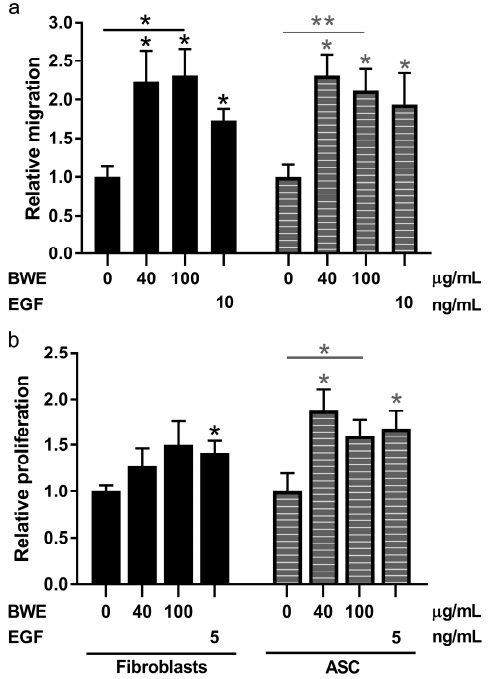
Figure 5. Migration scratch assay and proliferation assay using dermal fibroblasts and adipose tissue-derived mesenchymal stromal cells. ( a ) Relative migration values of fibroblasts and Adipose tissue-derived mesenchymal Stromal Cells (ASC) cultured in the presence of BWE or epidermal growth factor (EGF); ( b ) Relative proliferation values of fibroblasts and ASC cultured in the presence of BWE or EGF. The 5 and 10 ng/mL concentrations of EGF are optimal concentrations to serve as a positive control for the proliferation and migration experiments respectively. Significance of the dose response curve was calculated using a one-way ANOVA followed by a Dunn’s multiple comparison test and significance of EGF induction was tested with a t -test; * p < 0.05, ** p < 0.01. Data is shown for 4 independent experiments as mean ± SEM. Each experiment represents a different cell donor and a different BWE donor (see Table 1). Black, solid bars represent fibroblasts and grey, striped bars ASC.